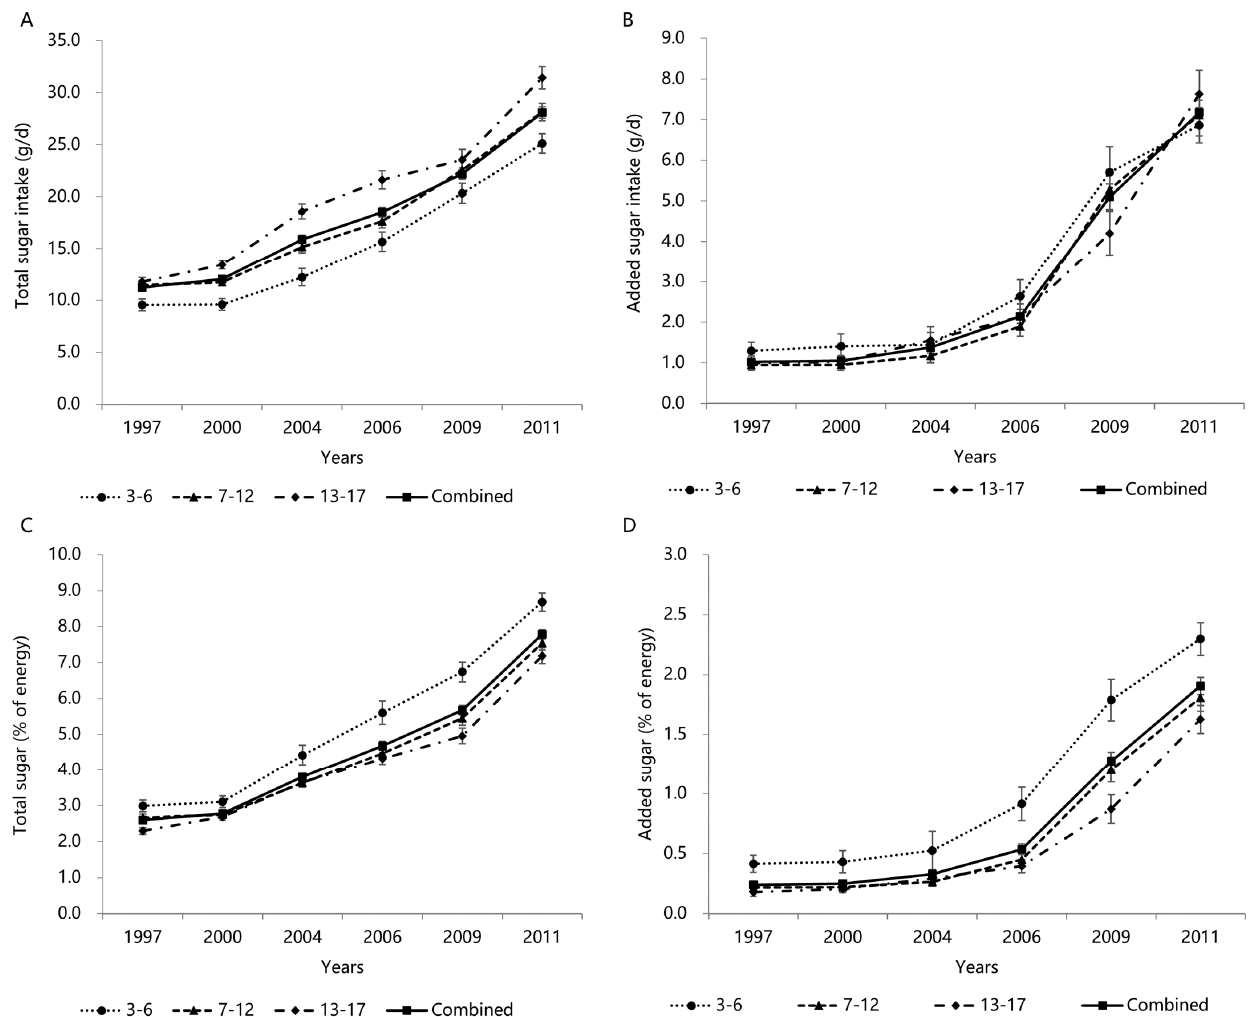
Figure 1. Mean ( ± SE) trends in total sugar intake ( A ), added sugar intake ( B ), total sugar (%E) ( C ), and added sugar (%E) ( D ) in Chinese children and adolescents by age group, CHNS 1997–2011. All results of linear trends by using general linear regression were p < 0.001.